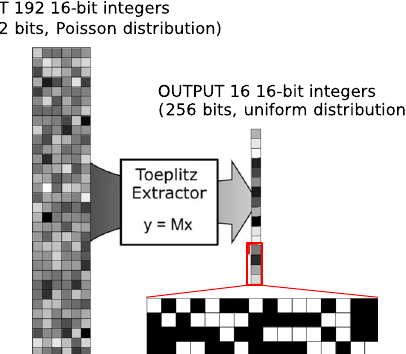
Fig. 5 Visualization of the random number extraction process. 256 uniform random bits ( y ) are generated from 3072 input bits ( x ), captured as 192 16-bit integers. The extraction is performed using a 256 × 3072 Toeplitz matrix 40 ( M ), which simultaneously removes any bias from the input sequence, and excludes the impact of non-quantum noise sources. Input and output integer sequences are shown here in greyscale representation, and we further expand 64 bits of the output to show a binary representation.